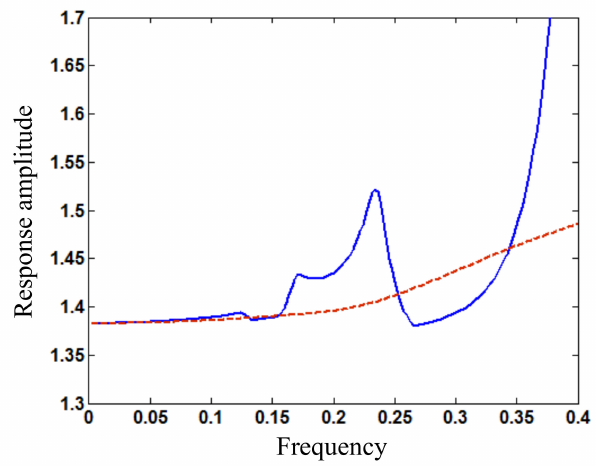
Figure 14. Amplitude ( w Am ) frequency ( ω ) relation around fractional harmonic resonance for loading amplitude F s 1 = 1.7 and different damping coefficients c (blue solid line: c = 0.1; red dashed line: c =